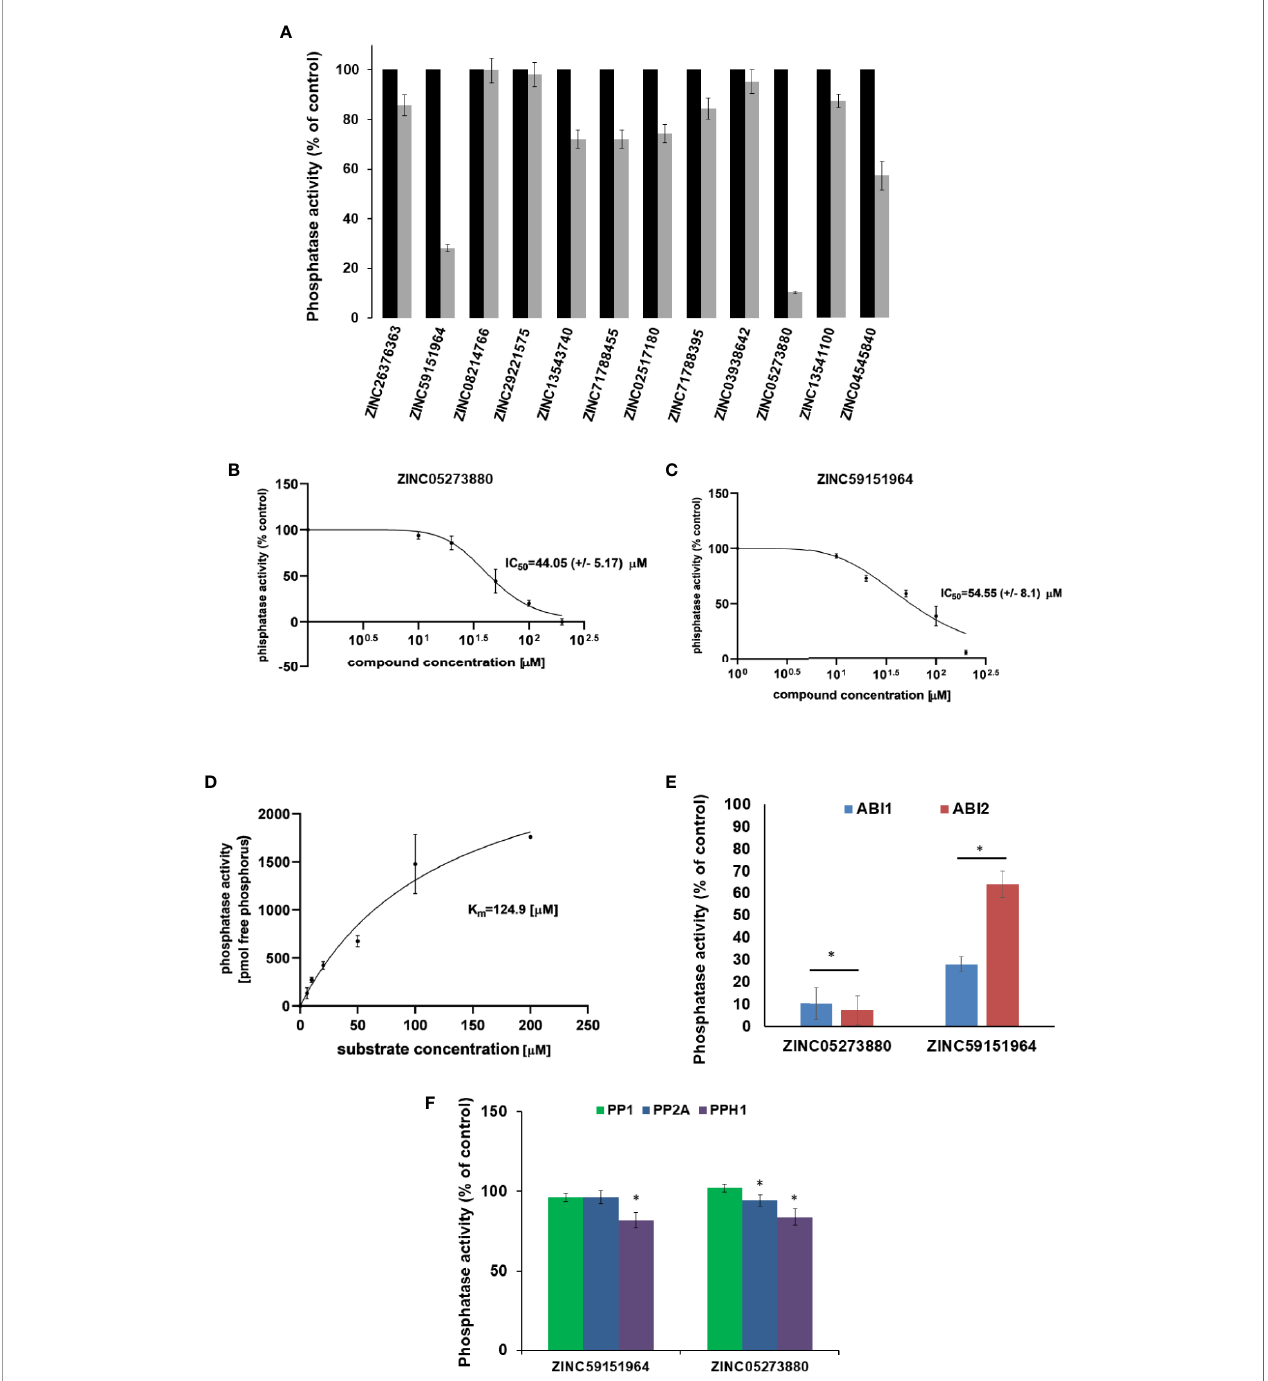
FIGURE 5 | Effect of Candidate Inhibitors on ABI1 Protein Phosphatase Activity. (A) Normalized results of phosphatase activity in the presence of each potential PP2C inhibitor are shown. Phosphatase activity was obtained from three independent biological replicates. IC50 was determined for six different concentrations of ZINC05273880 (B) and ZINC59151964 (C) , respectively, in the range 0 to 200 µM. Results are an average value of two independent experiments (n = 12). IC50 was determined by setting the inhibition rate of phosphatase activity versus inhibitor concentration. Error bars represents standard deviation. (D) K m value for ABI1 in a substrate range from 0 to 200 µM; (E, F) Effect of ZINC05273880 and ZINC59151964 on ABI1, ABI2 and non-clade A PP2Cs. Recombinant ABI1, ABI2, PP1, PP2A, and PPH1 proteins were assayed with (100 µM) and without (control) the indicated ZINC compounds. Values are expressed as a percentage of control and as the mean of two independent experiments (n = 6 – 12). The asterisks marks a signi fi cant difference by Student ’ s t-test (p <